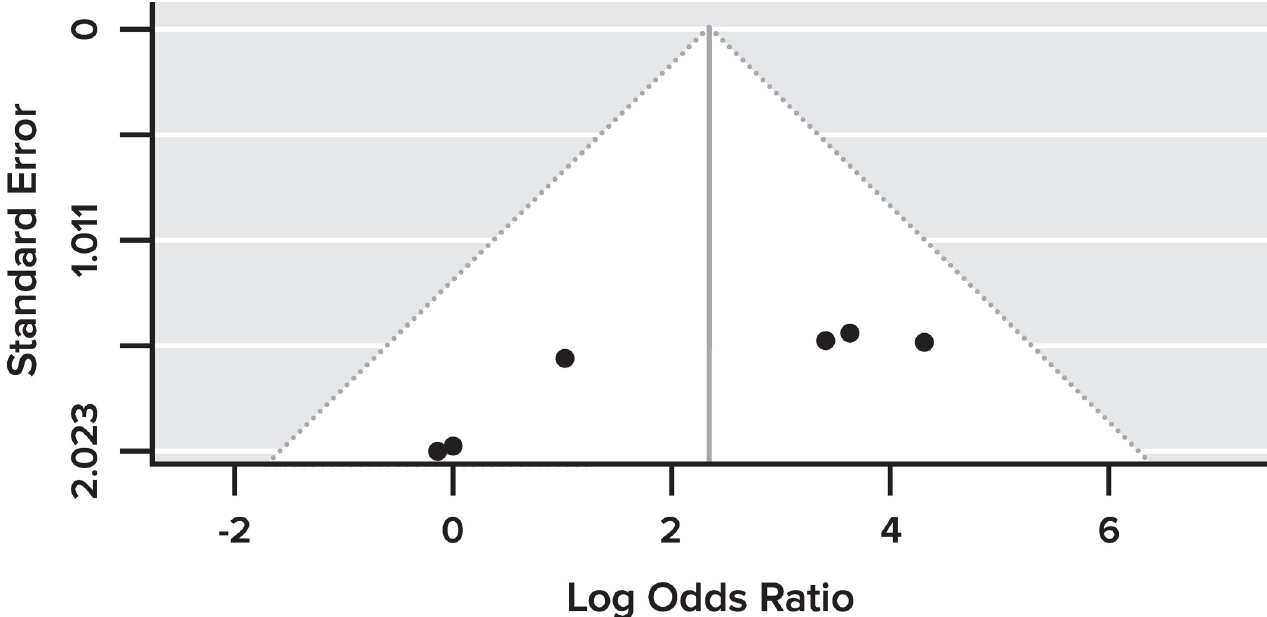
Fig 3. The funnel plot for the assessment of publication bias for the 5 studies included in the